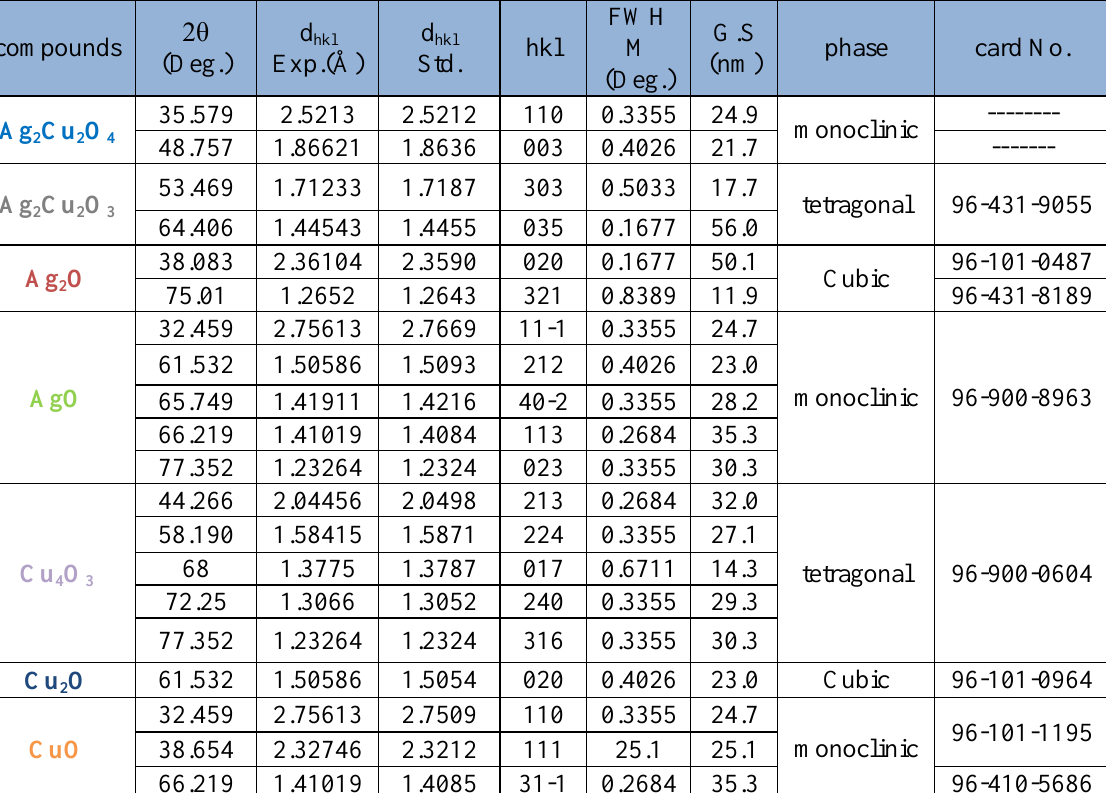
Table 3: Structural parameters viz. inter-planar spacing, crystallite size and Miller indices of Ag Cu O powder at sintered at 600 °C. 2 2 4 2θ compounds